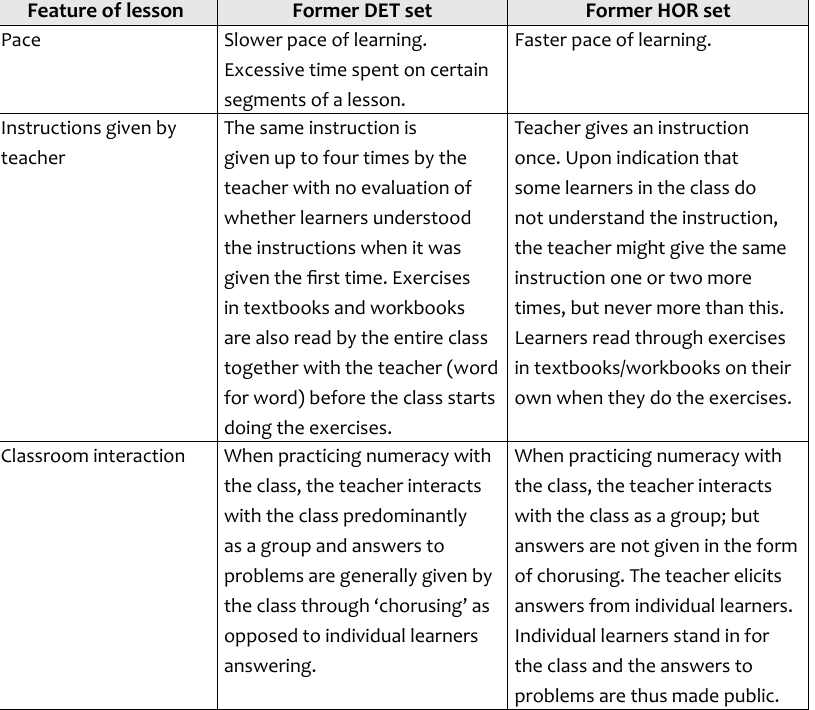
Table 2: General differences between DET set and HOR set in the sample Feature of lesson Former DET set Former HOR set Pace Slower pace of learning. Faster pace of Excessive time spent on certain segments of a lesson.